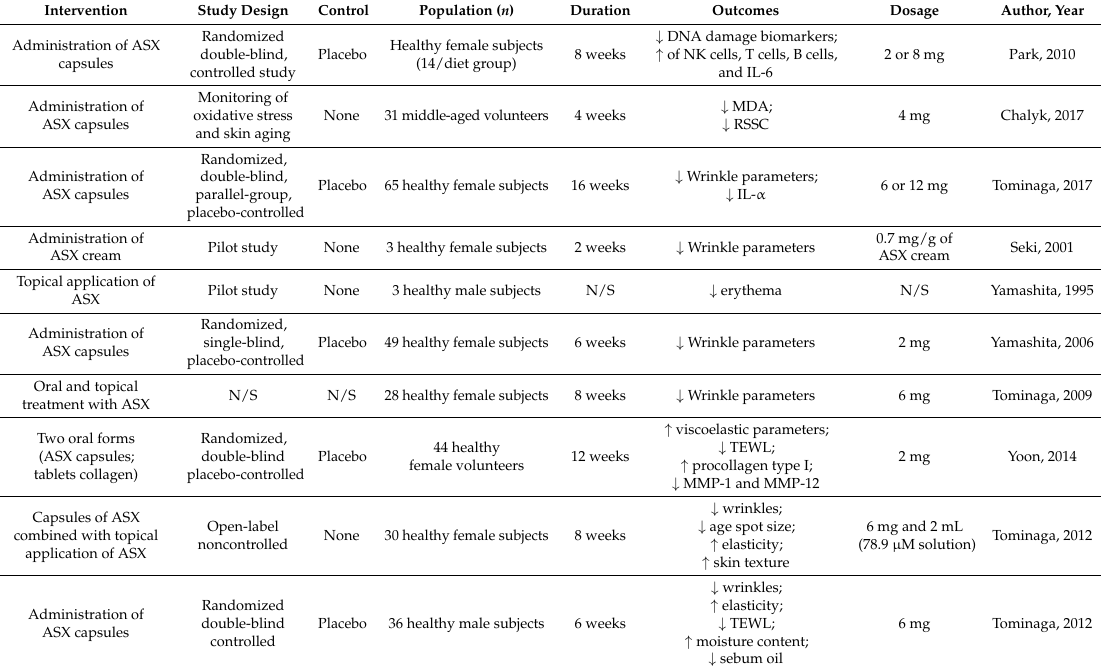
Table 1. Summary of human intervention studies on skin and